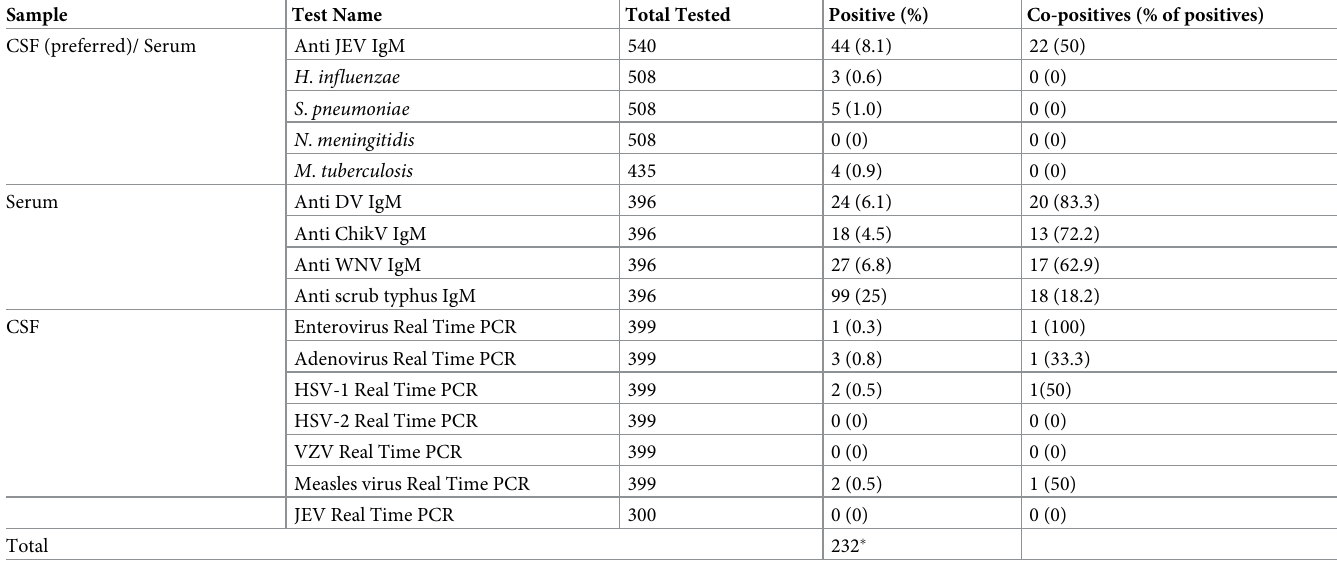
Table 3. Laboratory results of AES cases from